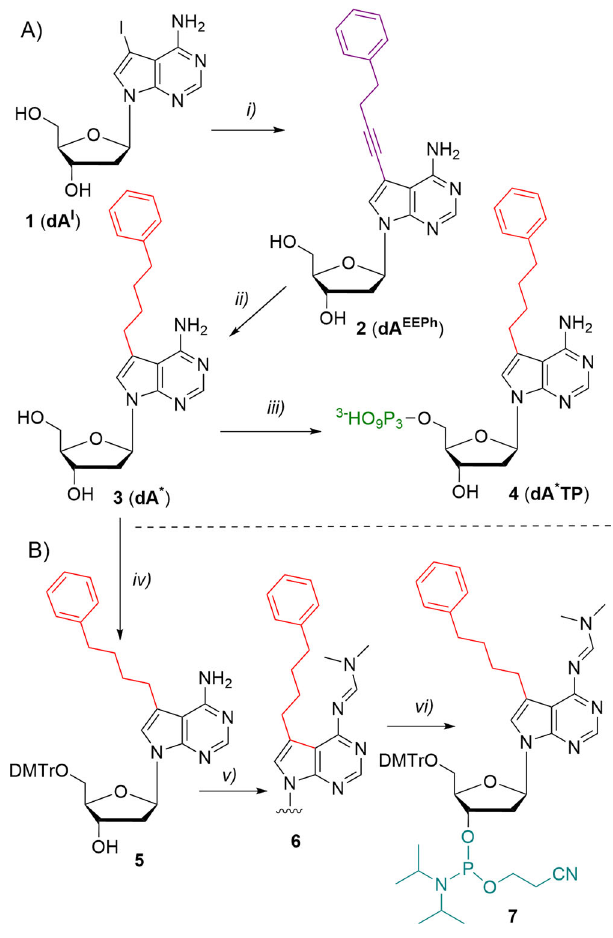
Fig. 1 Synthesis of PhBu-modi fi ed dA * TP and phosphoramidite 7. Reagents and conditions A : (i) but-3-yn-1-ylbenzene (10 equiv.), Pd(OAc) 2 (0.1 equiv.), CuI (0.1 equiv.), TPPTS (0.1 equiv.), TEA (6 equiv.), MeCN/